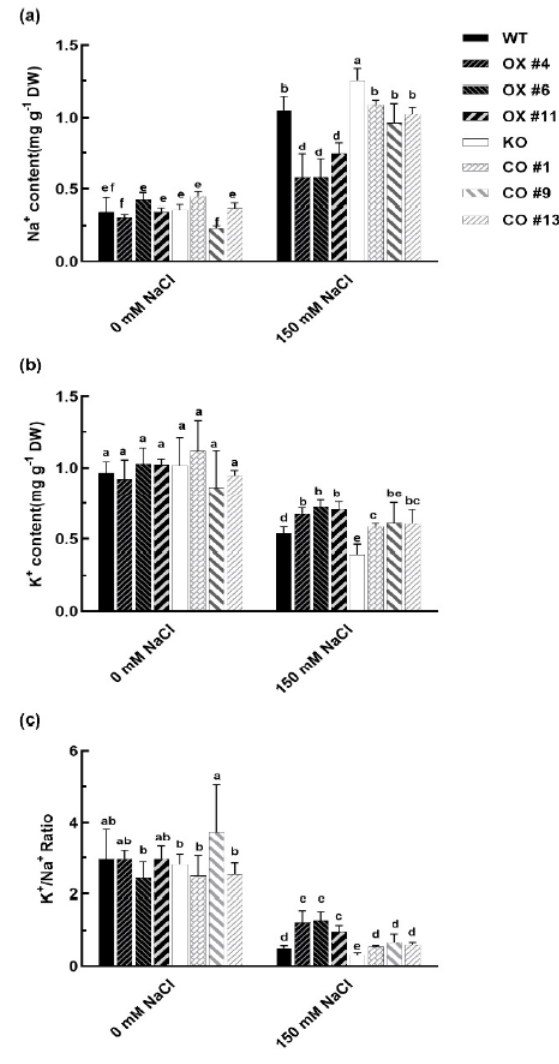
Figure 5. Na+ and K+ contents in the leaves of wild type (WT), BvbHLH93 -overexpression Arabidopsis (OX), atbhlh93 mutant (KO), and transgenic BvbHLH93 in the mutant (CO) under salt stress. ( a ) Na + content of the leaves. ( b ) K + content of the leaves. ( c ) K + to Na + ratio of the leaves. Different letters indicate significant difference at p < 0.05. Three biological replicates were